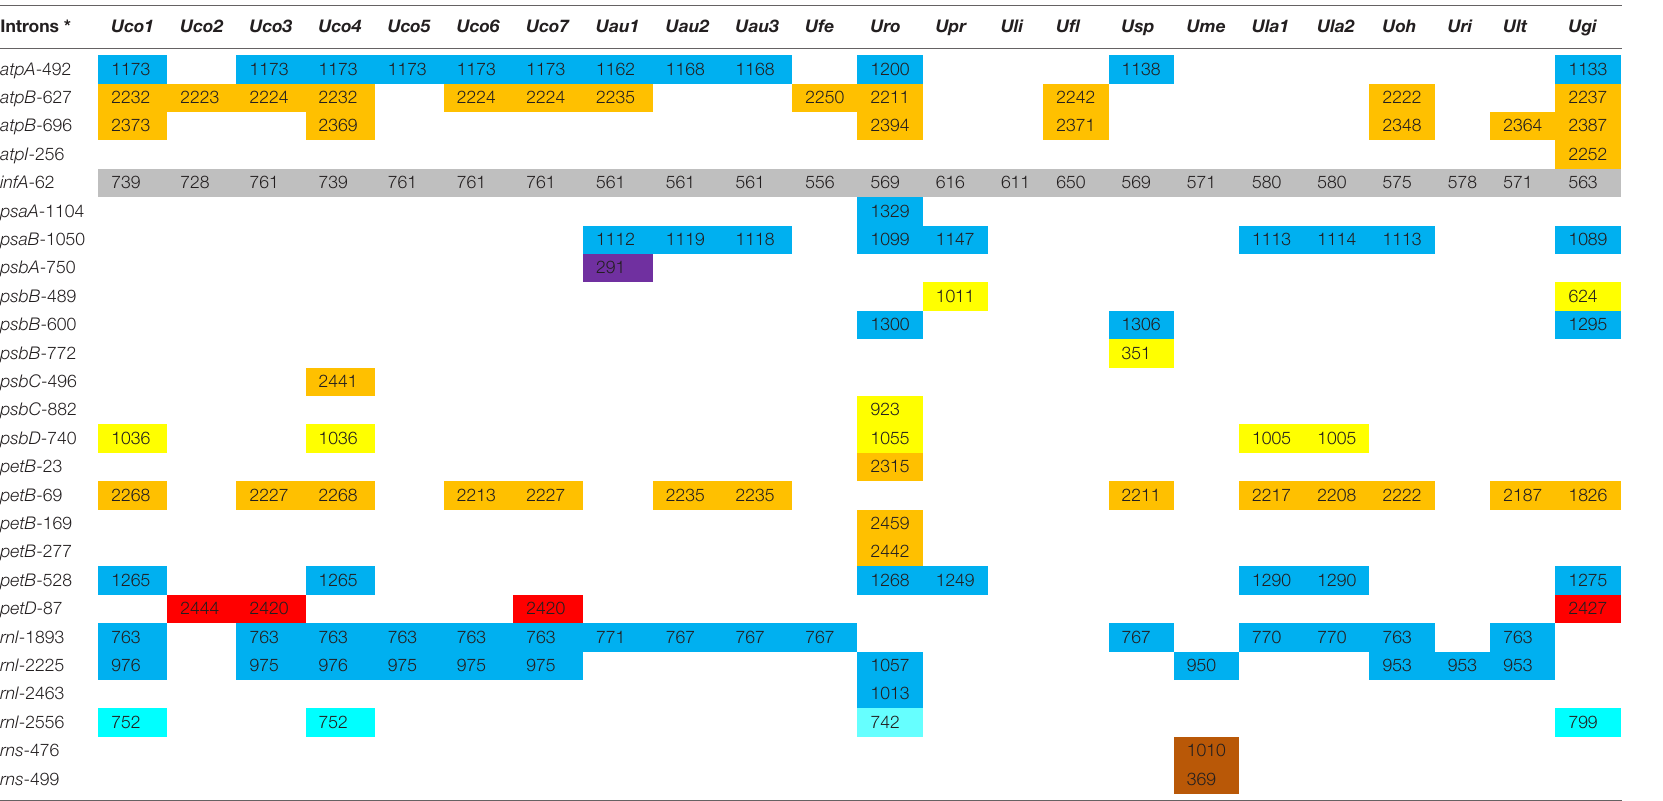
TABLE 3 | Comparison of insertion site, size and group of introns in the 23 Ulva chloroplast